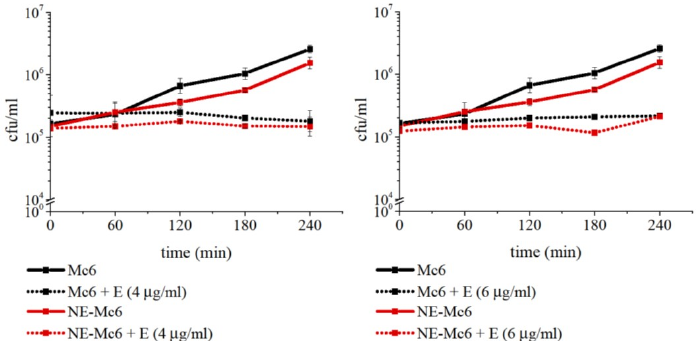
Figure 5. Enzymatic cleavage of surface protein McaP by neutrophil elastase (NE) does not sensitize M. catarrhalis to erythromycin. The curves on activity of erythromycin against WT log phase bacteria pre-treated (1 h, 37 °C) with 2 µM NE and then incubated for 4 h with antibiotic are shown. Data are expressed as mean cfu/mL ± SD from two independent experiments performed in triplicate.